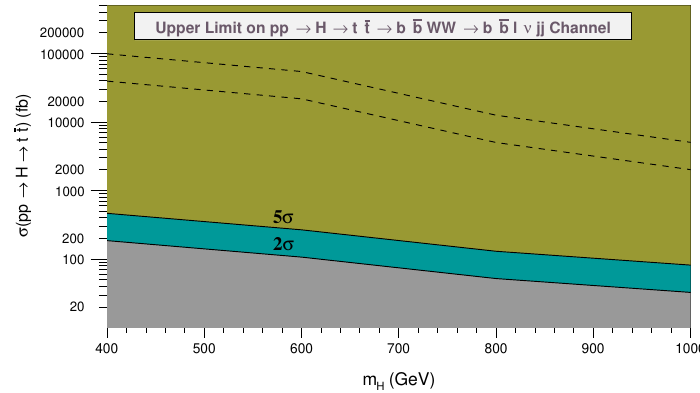
Figure 34 . Upper limit on (cid:27) ( pp channel. The solid (dashed) lines show the 2 (cid:27) -5 (cid:27) band on taking 0% (5%) systematic uncertainties.